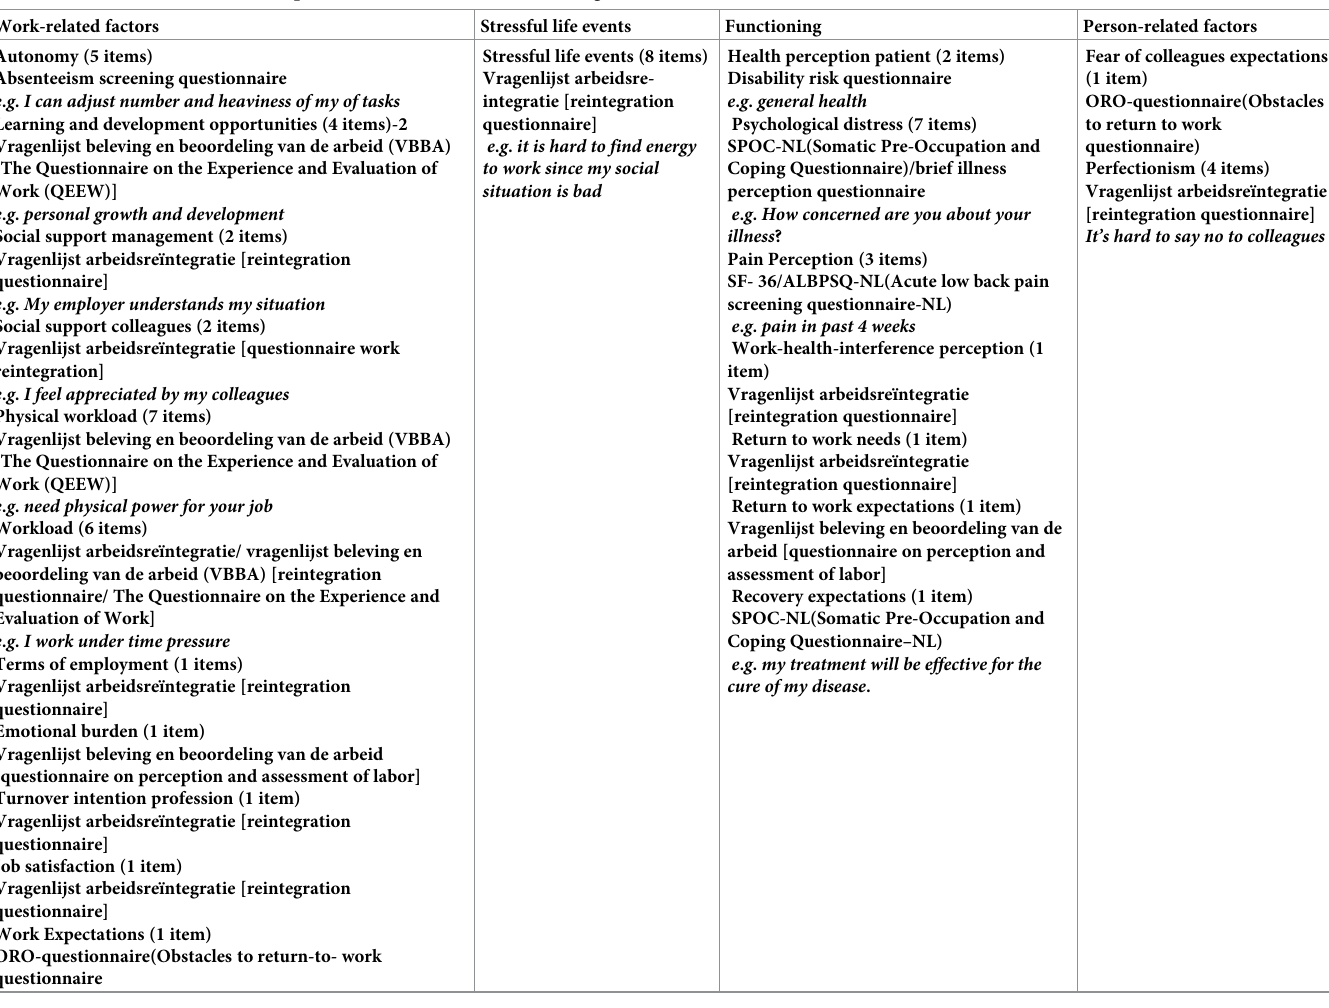
Table 1. Structure, content, source-questionnaires and Quickscan scoring � . Work-related